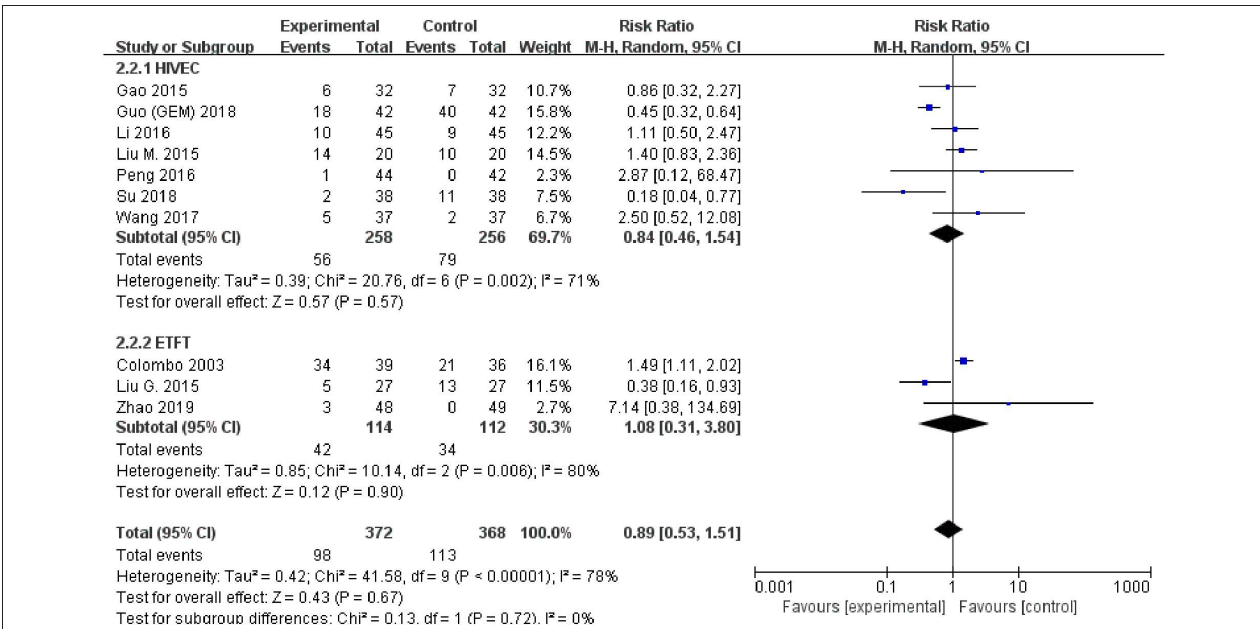
FIGURE 8 | Comparison on adverse event rate between thermal intravesical chemotherapy and normal temperature intravesical chemotherapy after subgroup analysis stratified by different approach used in thermal therapy.